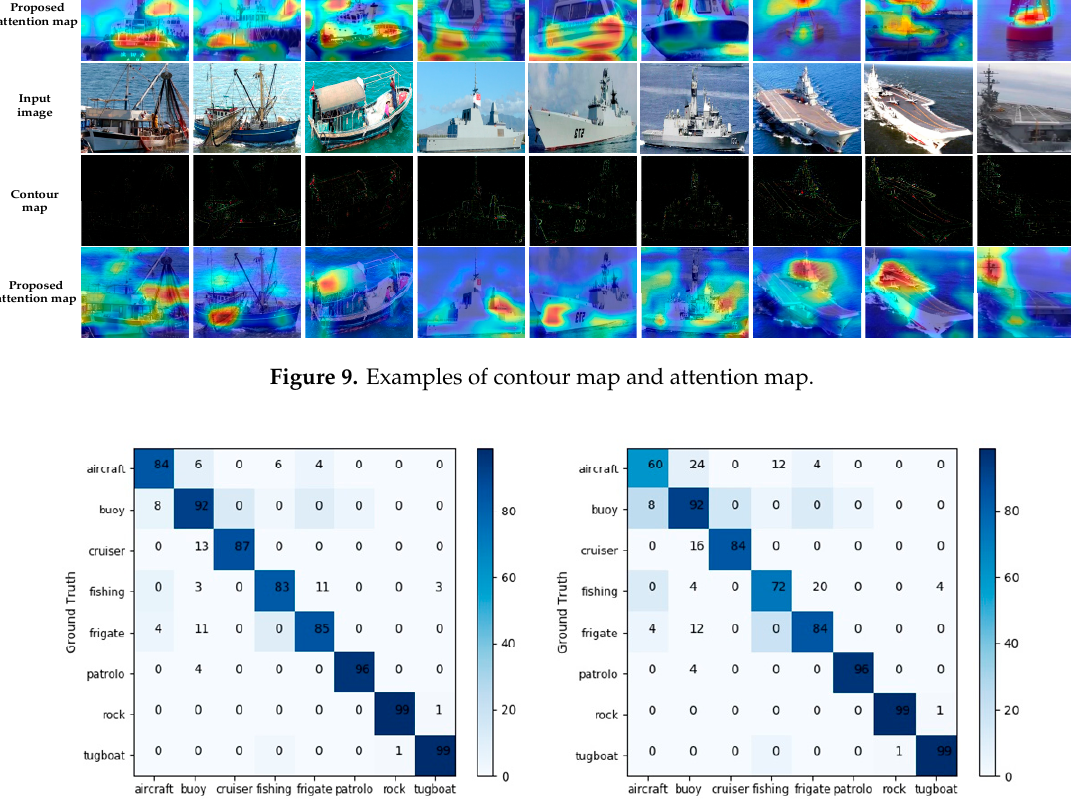
Figure 9. Examples of contour map and attention map.